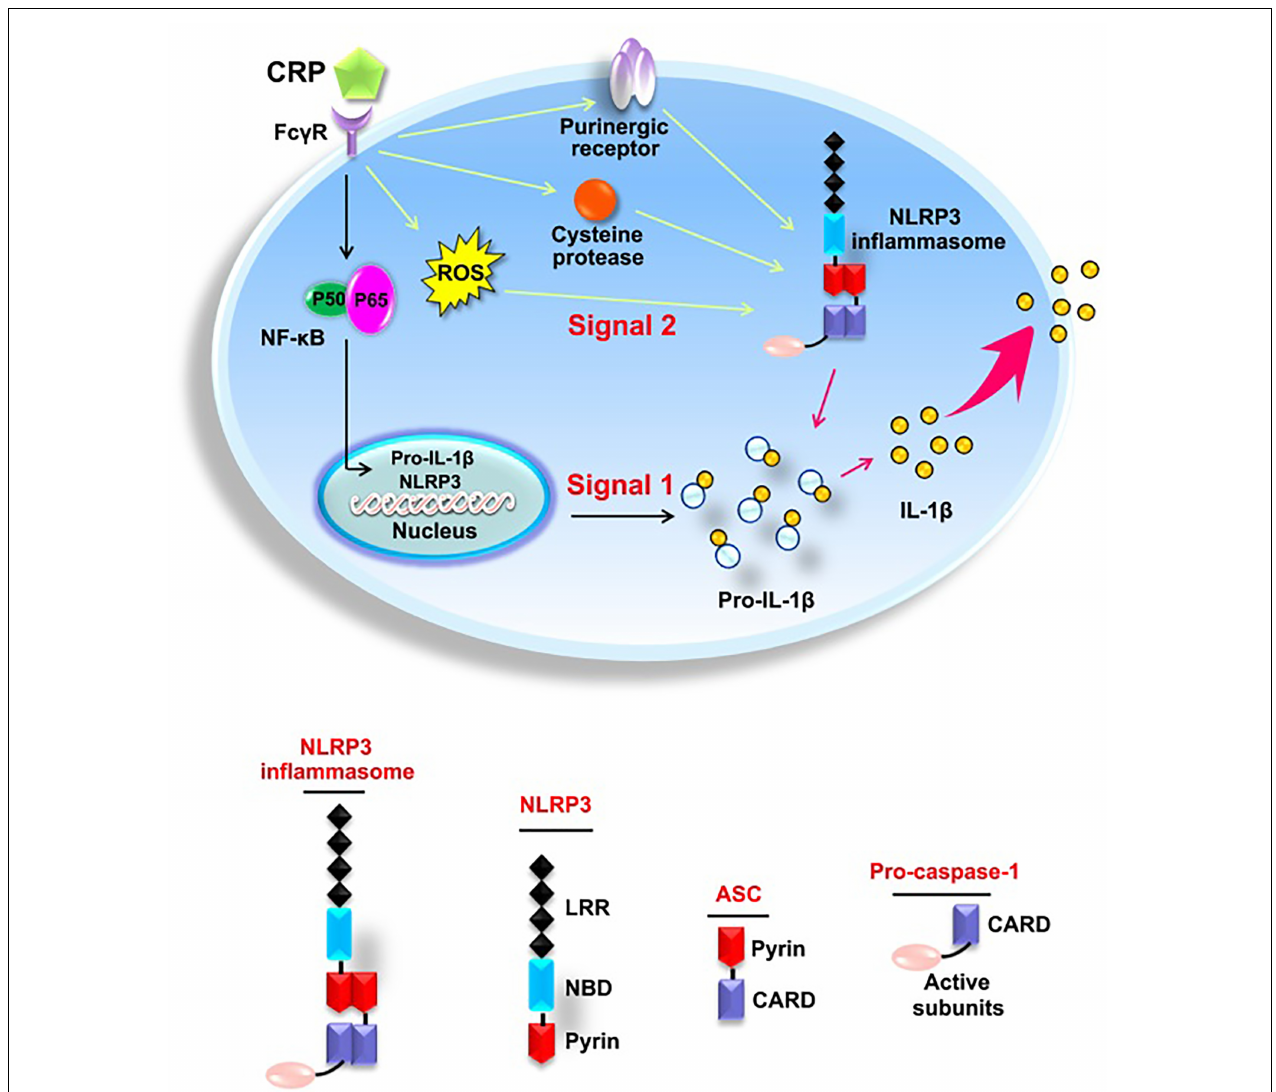
FIGURE 7 | Schematic diagram of CRP-induced NLRP3 inflammasome activation.